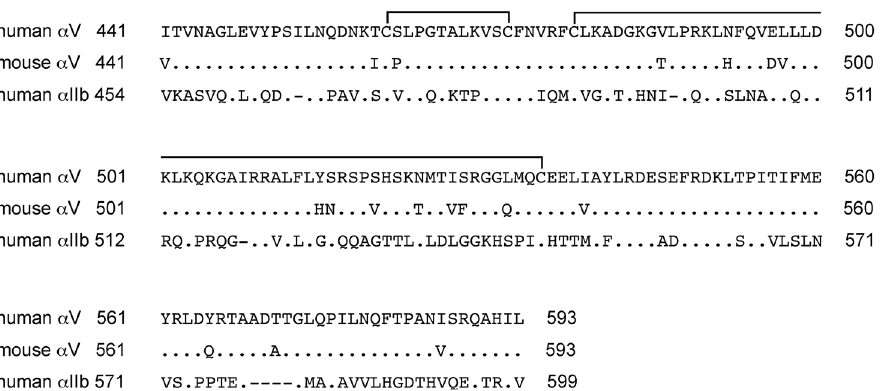
Figure 2. Comparison of amino acid sequences comprising the thigh domains. We show the amino acid residues 441 to 593 of the human and the murine a V chain compared with the homologous residues 454 to 599 of the human a IIb chain that differ from the human a V residues. The line connecting two Cys residues represents a disulfide link.